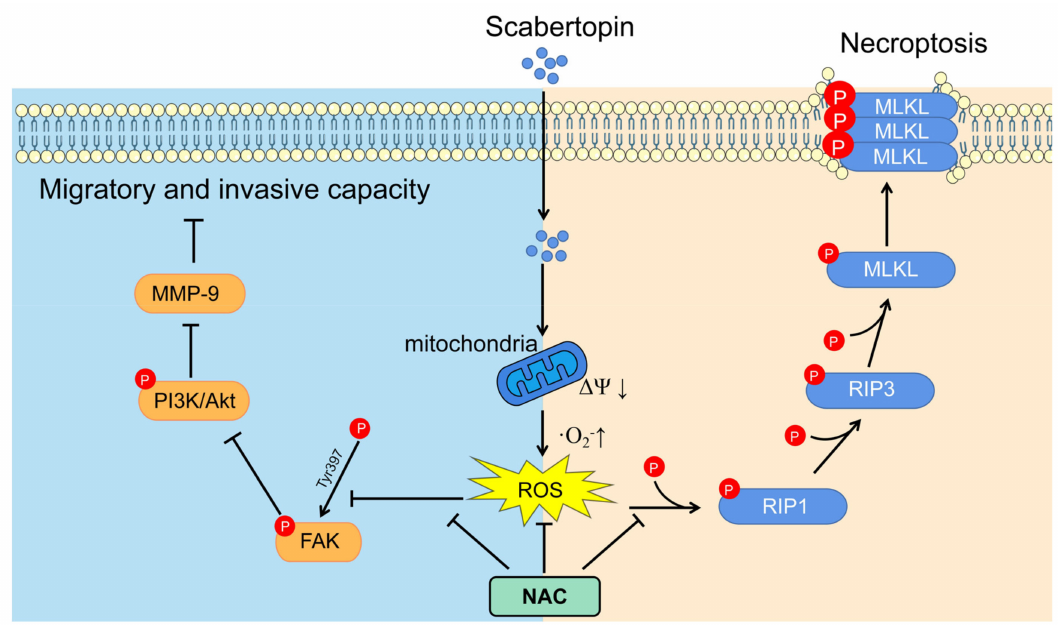
Figure 6. Mechanism of scabertopine inhibiting invasion and promoting necroptosis in human bladder cancer J82 cells. Scabertopin can reduce mitochondrial membrane potential and stimulate mitochondrial ROS production, thereby activating RIP1/RIP3/MLKL phosphorylation, mediating J82 cell necroptosis, and inhibiting the FAK/PI3K/Akt/MMP-9 signaling pathway. This in turn inhibits the migration and invasive potential of J82 cells. Akt: Akt-protein kinase B; FAK: focal adhesion kinase; MLKL: mixed lineage kinase like; MMP-9: matrix metalloprotease 9; NAC: N -acetylcysteine; PI3K: phosphoinositide 3-kinase; p-: phosphorylated; RIP: receptor-interacting